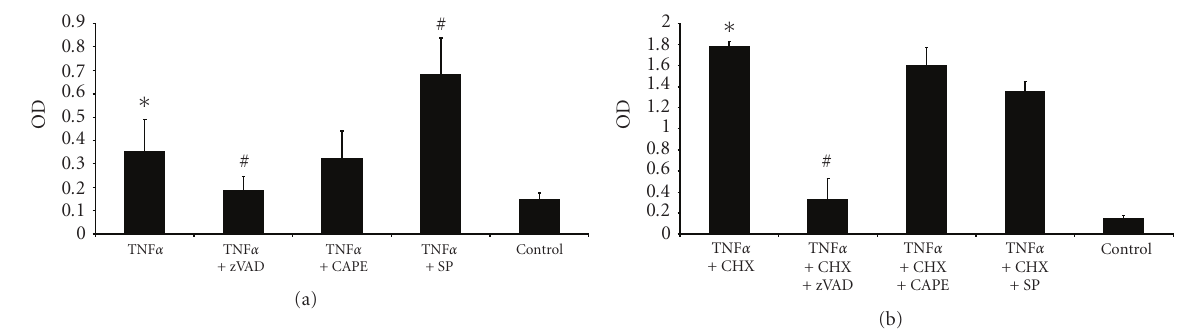
Figure 5: Caspase inhibition prevents TNF α -induced DNA fragmentation. Influences of inhibitors of caspases, NF- κ B, and JNK were analyzed in respect to TNF α -induced PCPEC DNA fragmentation. PCPECs were stimulated apically with TNF α (100ng/mL) with (b) or without (a) cycloheximide (1 μ g/mL). Cells were additionally preincubated with zVAD (10 μ M), CAPE (5 μ M) or SP600125 (10 μ M) for 2 hours as indicated. Results of these experiments were measured as an optical density (OD). The data shown are mean ± SEM of three independent experiments, each performed in duplicate; # P-value of < . 05 compared to treated PCPEC without inhibitor.